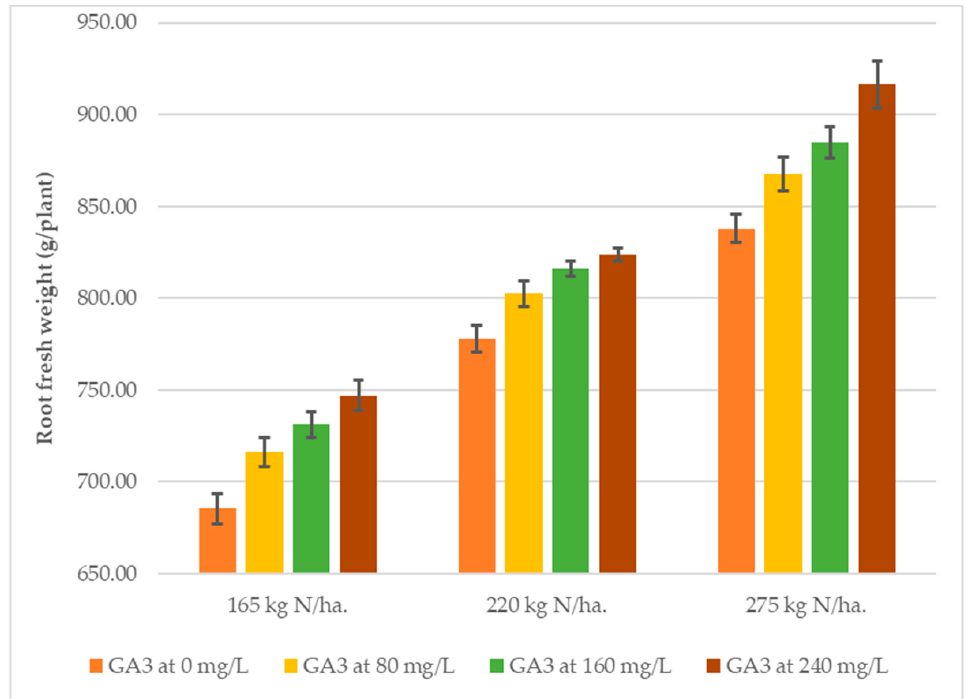
Figure 3. Root fresh weight (g/plant) as affected by the interaction between nitrogen fertilizer levels and GA 3 spraying concentrations in the second season (2015/2016).